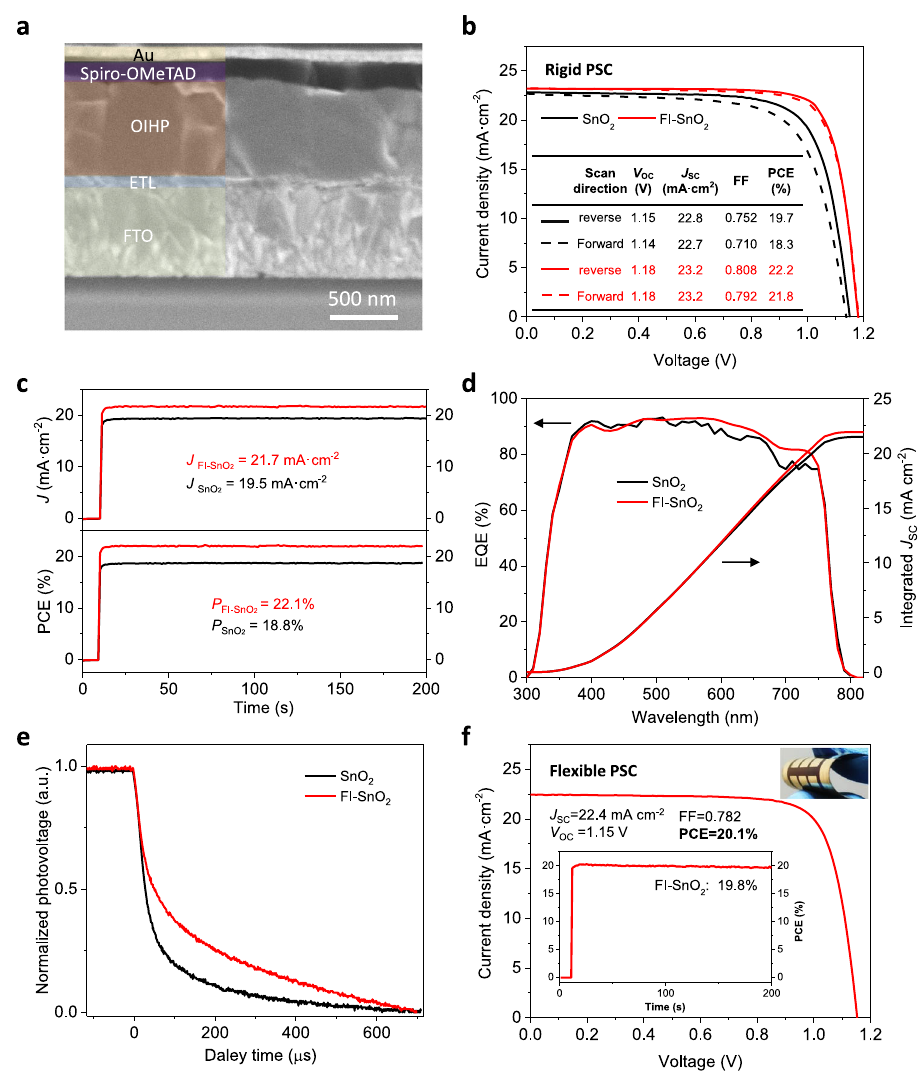
Fig. 4 Photovoltaic performance of rigid and fl exible solar cell devices. a Cross-sectional SEM image of a rigid PSC device based on FI – SnO 2 ETL. b J – V curves (forward and reverse scans) of rigid PSCs based on FI – SnO 2 and pristine SnO 2 ETLs. The inset table shows the extracted PV parameters. c MPP current/PCE outputs, and d EQE spectra of the champion rigid PSCs based on FI – SnO 2 and pristine SnO 2 ETLs. e Transient photovoltage decays for PSCs based on FI – SnO 2 and pristine SnO 2 ETLs. f J – V curve and MPP PCE output of the champion fl exible PSCs based on FI – SnO 2 ETL. Inset is the photograph of a fl exible PSC